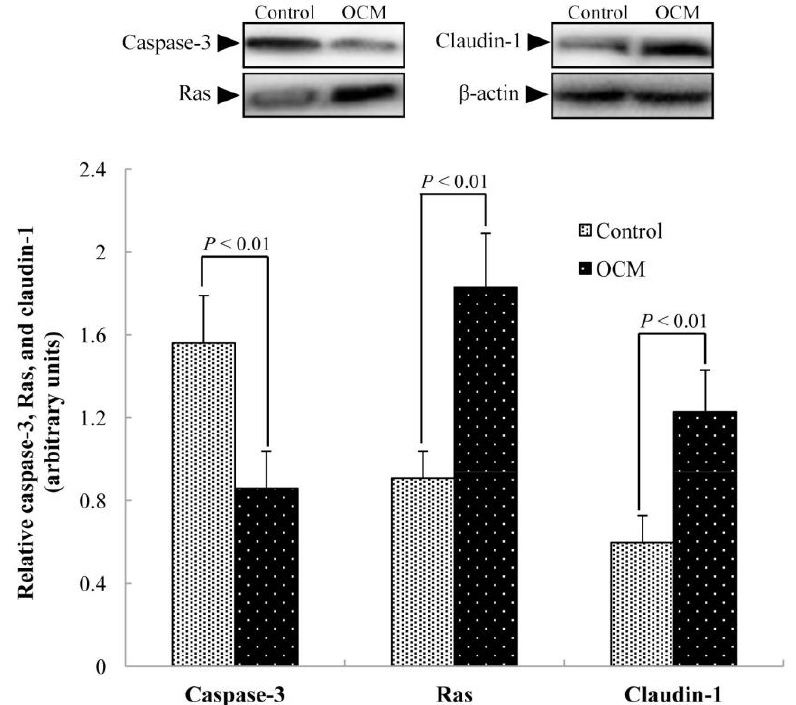
Figure 3. Abundances of caspase-3, claudin-1, and Ras in the jejunal mucosa of piglets. Dietary supplementation with oleum cinnamomi (OCM, 50 mg/kg diet) increased the abundance of Ras and claudin-1 proteins, but decreased the abundance of caspase-3 in the jejunum. Data are means ± SD, n = 8.